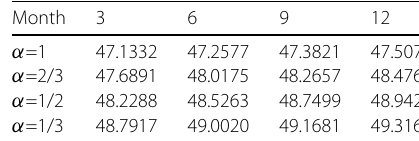
Figure 8 The option price calculated by PASE-I